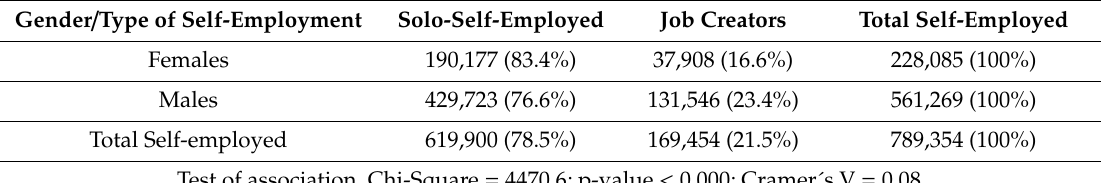
Table 1. Association between gender and type of self-employment (age range 15–64 years; absolute numbers and row percentage shares in brackets).